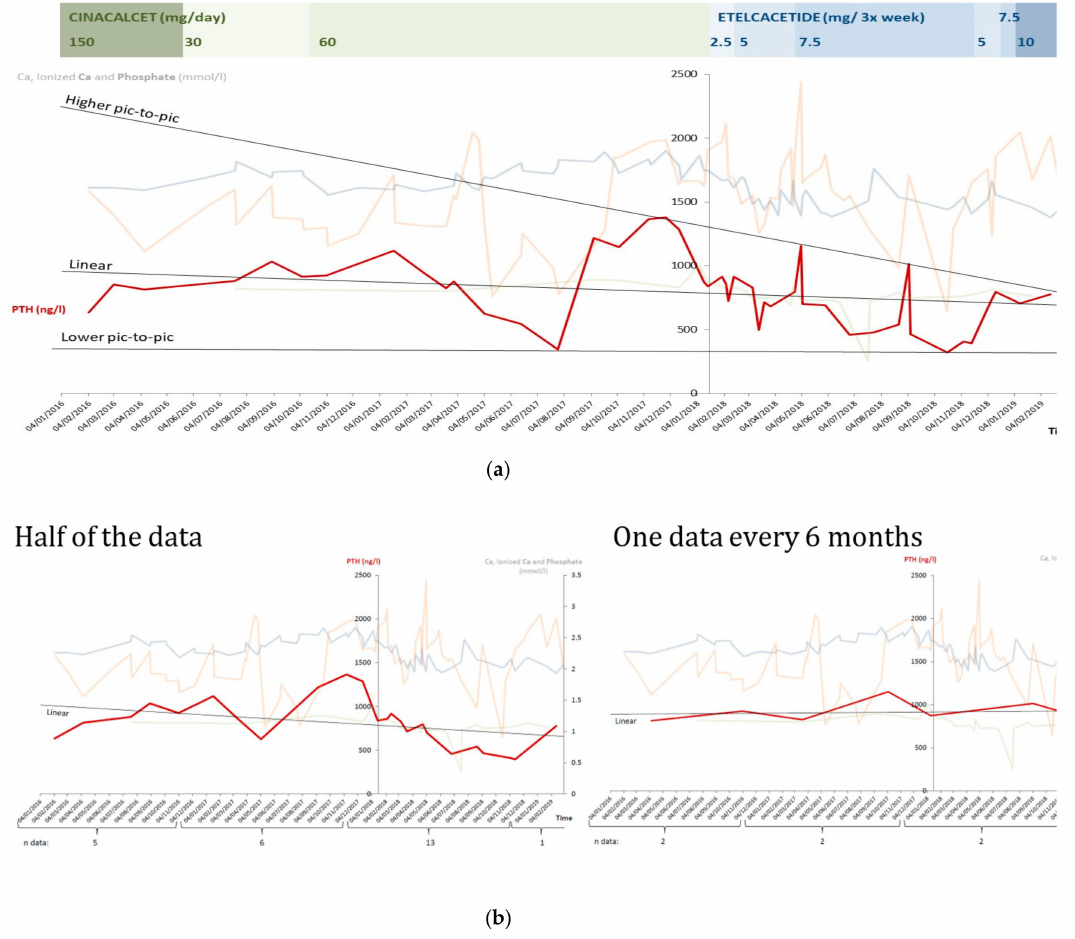
Figure 3. Di ff erent trends of PTH in the same case, according to the modality of analysis. Legend: Ca calcium; PTH parathyroid hormone. ( a ): all PTH data available; ( b ): limited PTH data available. Overall the treatment lowered PTH levels, the exceptions being patients who started treatment in the context of hypercalcemia (Figure